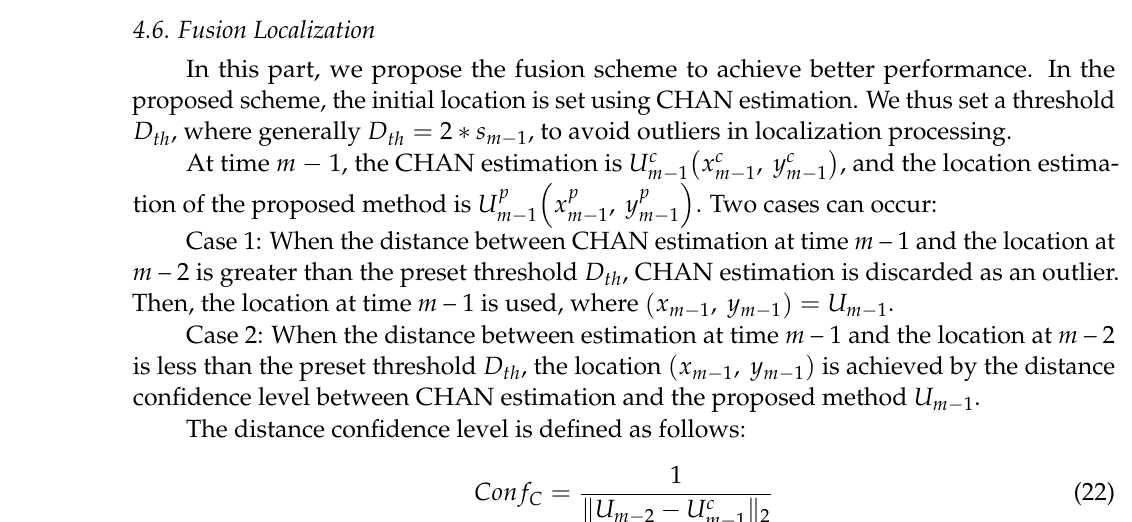
Figure 5. Localization of the proposed heading direction method with different devices. ( a ) VivoY85a cell phone. ( b ) Honor60 cell phone.